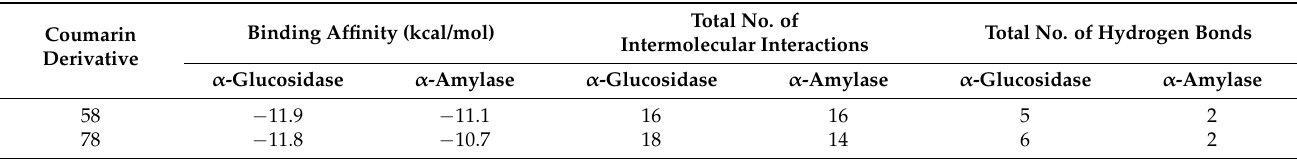
Table 2. Virtual screening of coumarin derivatives against α -glucosidase (PDB ID: 3A4A) and α -amylase (PDB ID: